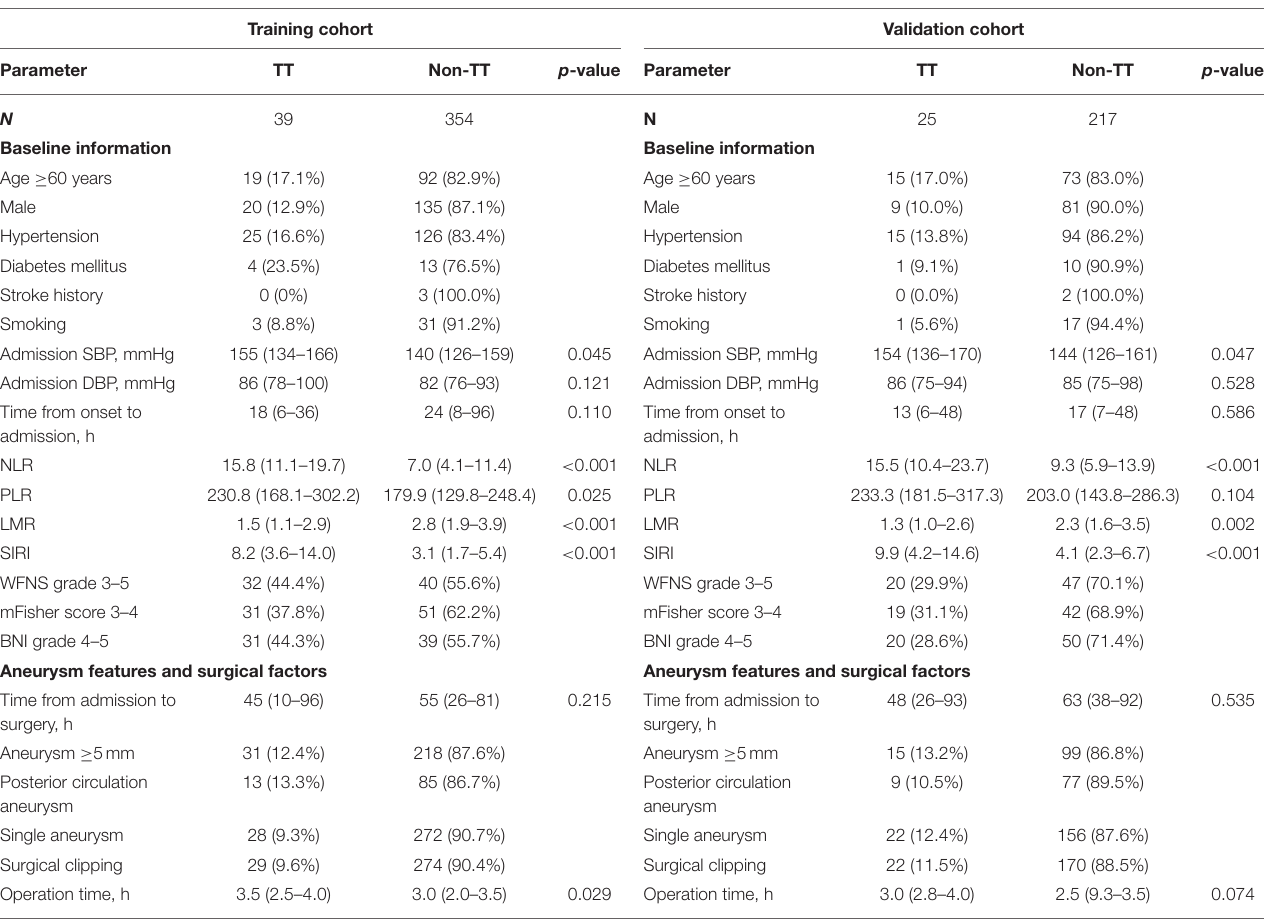
TABLE 2 | The demographic and clinical variables of training and validation